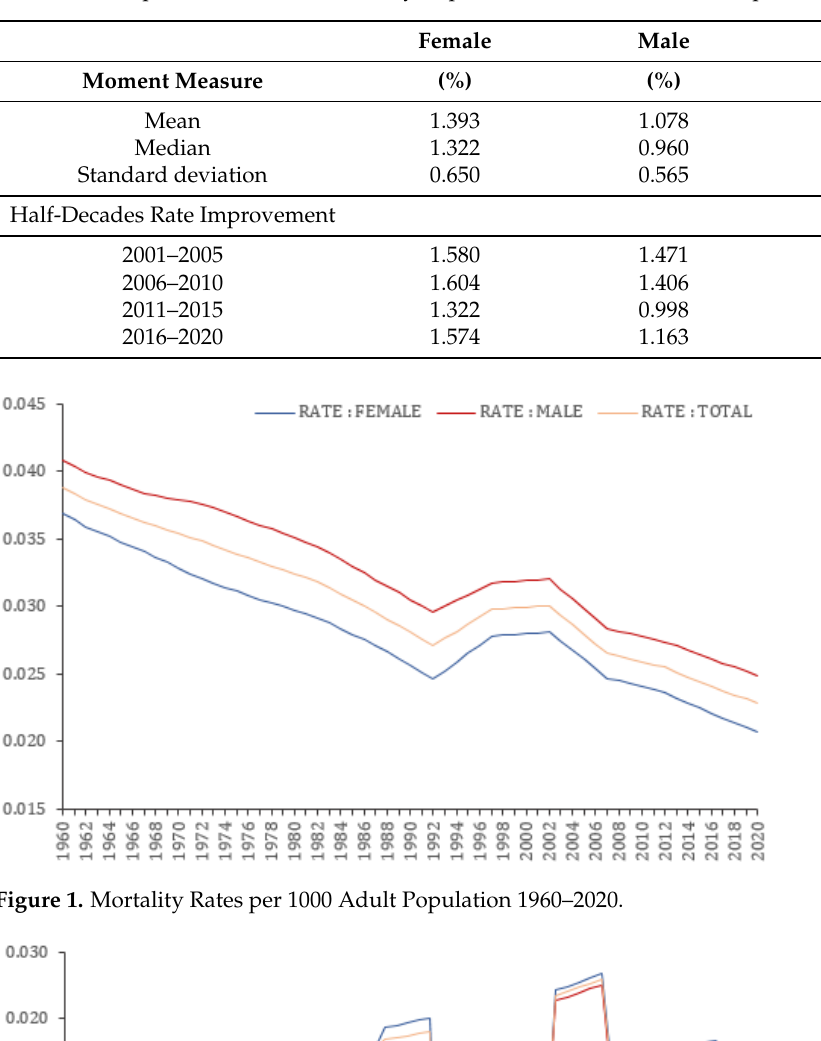
Table 1. Descriptive Statistics on Mortality Improvement in the Ghanaian Population (1960–2020).